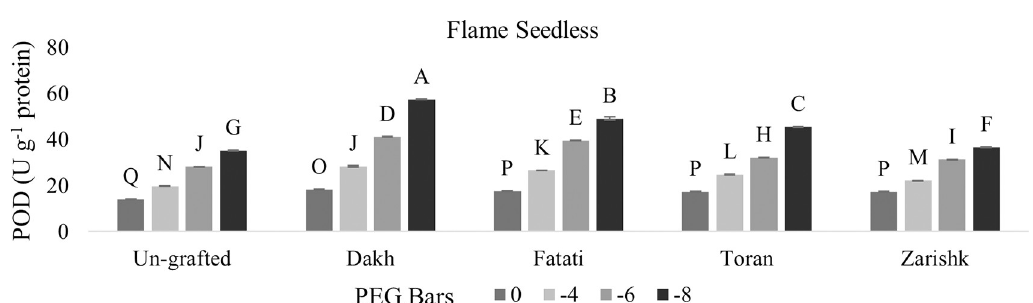
Fig 16. Ascorbate peroxidase (POD) enzymatic activity of un-grafted and grafted Flame Seedless scion variety grafted on different wild grapevines under drought stress condition. Data is represented as mean SD and letters showed significant difference at p <